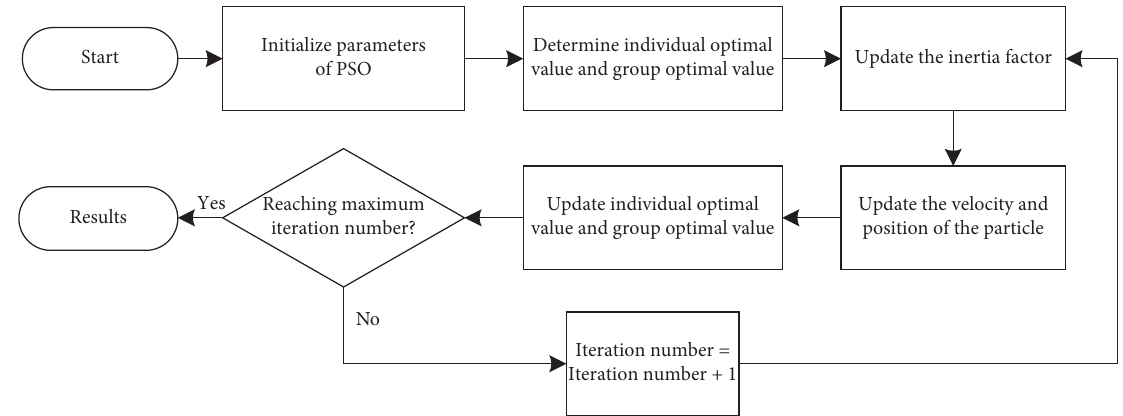
Figure 1: Flowchart of the PSO